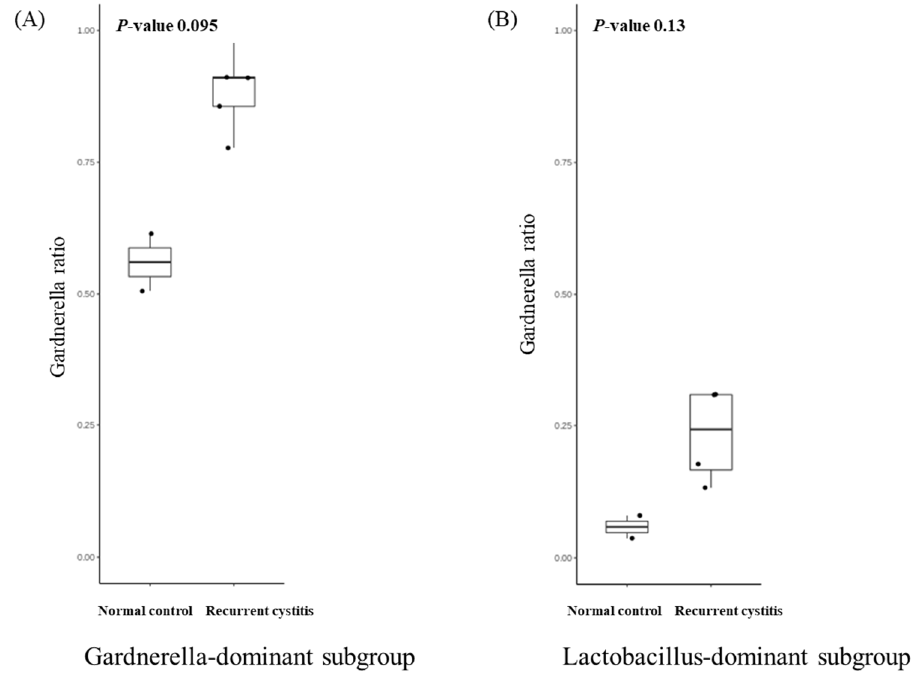
Figure 4. Relative abundance of Gardnerella in ( A ) Gardnerella -dominant subgroup and ( B ) Lactobacillus -dominant subgroup .